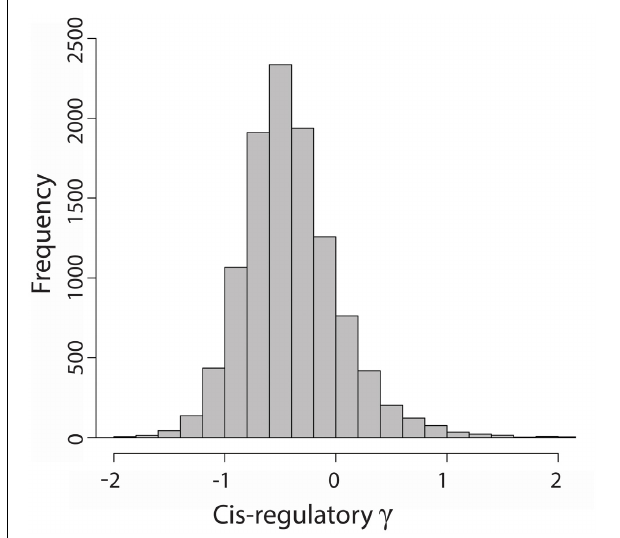
FIGURE 1 | Distribution of average population size scaled selection coefficients ( γ ) on cis -regulatory mutations in 10,807 genes in the honey bee genome. Ten genes with cis -regulatory γ > 2 were omitted from the histogram for